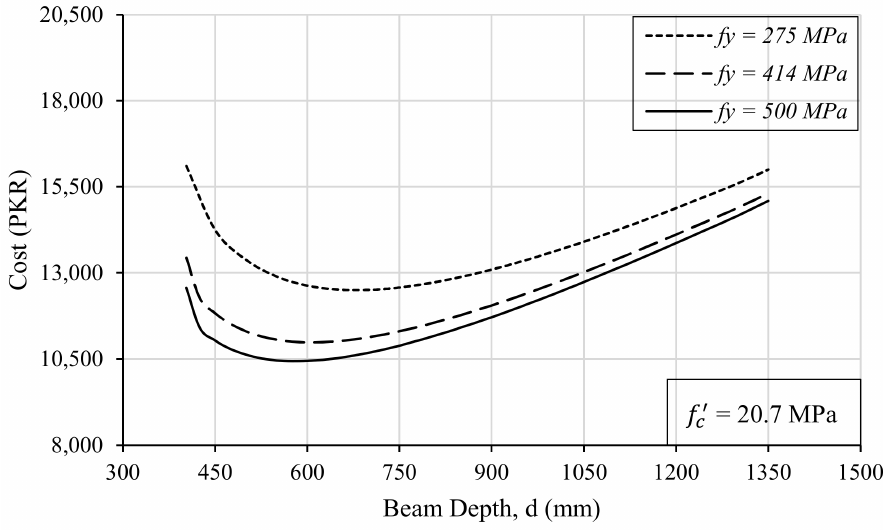
Figure 11. The effect of the steel strength on the depth and cost of the